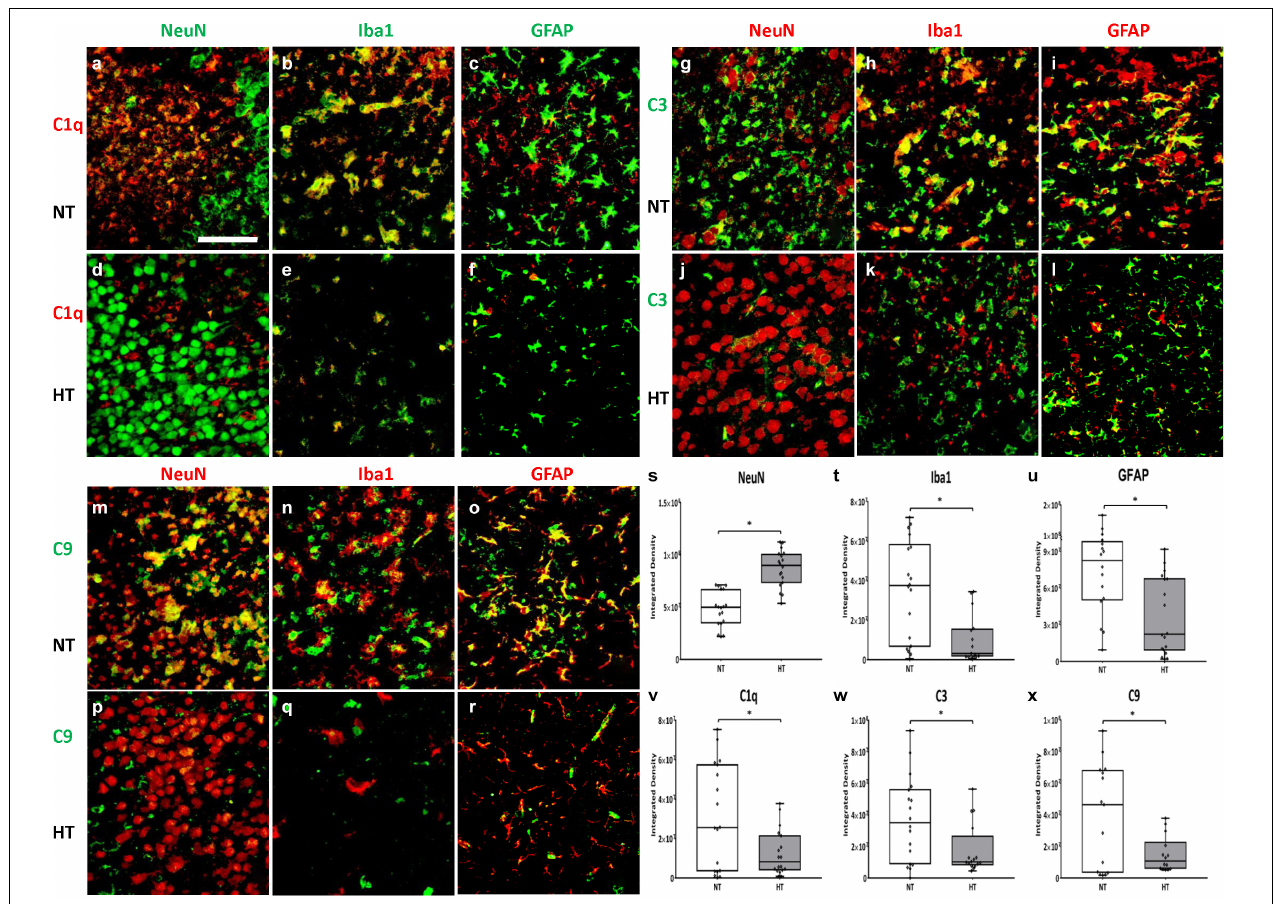
FIGURE 6 | HT decreases microglial expression of C1q, C3 and C9. HT treated animals (d,j,p) demonstrated a higher neuronal density when compared to NT (a,g,m) animals (s) . HT animals showed decreased evidence of local inflammation as demonstrated by reduced microglial numbers and size (e,k,q,t) and reduced astrogliosis (f,l,r,u) when compared to NT animals (b,c,h,i,n,o) . C1q primarily co-localizes in the microglia (b,e) , with scant co-localization in neurons (a,d) and astrocytes (c,f) . C3 primarily co-localizes in the microglia (h,k) and astrocytes (i,l) , with scant co-localization in neurons (g,j) . C9 extensively co-localizes with neurons (m,p) , microglia (n,q) and astrocytes (o,r) . HT animals showed decreased expression of C1q (v) , C3 (w) and C9 (x) when compared to NT animals. [Ipsilateral hemispheres, cortex and hippocampus, 48 h after injury; n = 4 per group, 10 fields per brain, Magnification -40X; Green = NeuN (a,d) , C3 (g–l) , Iba1 (b,e) , GFAP (c,f) , C9 (m–r) Red = C1q (a–f) , NeuN (g,j,m,p) , Iba1 (h,k,n,q) , GFAP (i,l,o,r) ; White bar – HIE, Gray bar – HT. Scale bars: 50 µ m; error bars denote ± SD, * denotes P <